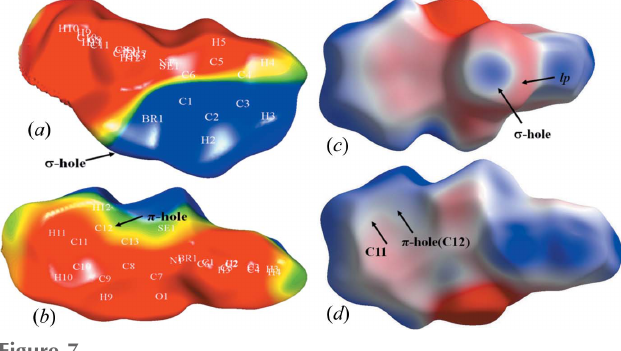
Figure 7 Experimental and theoretical MESPs drawn at (cid:8) 0.05 a.u., with blue corresponding to positive electrostatic regions and red to negative electrostatic regions. ( a ), ( c ) The (cid:2) -hole and l.p. of the Br atom. ( b ), ( d ) The (cid:3) -hole and electron-rich region along the C11—C12